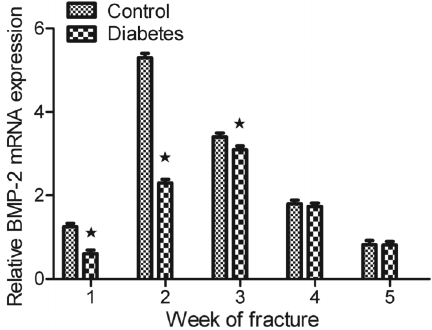
Figure 6. Fluorogenic quantitative polymerase chain reaction results of transforming growth factor b 1 (TGF- b 1) mRNA expression in the two groups. TGF- b 1 gene expression in the diabetes group was lower than in the control group at postoperative weeks 1, 2, 3 (*P o 0.05, t -test). However, there was no statistical difference at weeks 4 and 5. TGF- b 1 expression achieved its highest level at week 4 in the diabetes group, but reached its highest level at week 3 in the control group.